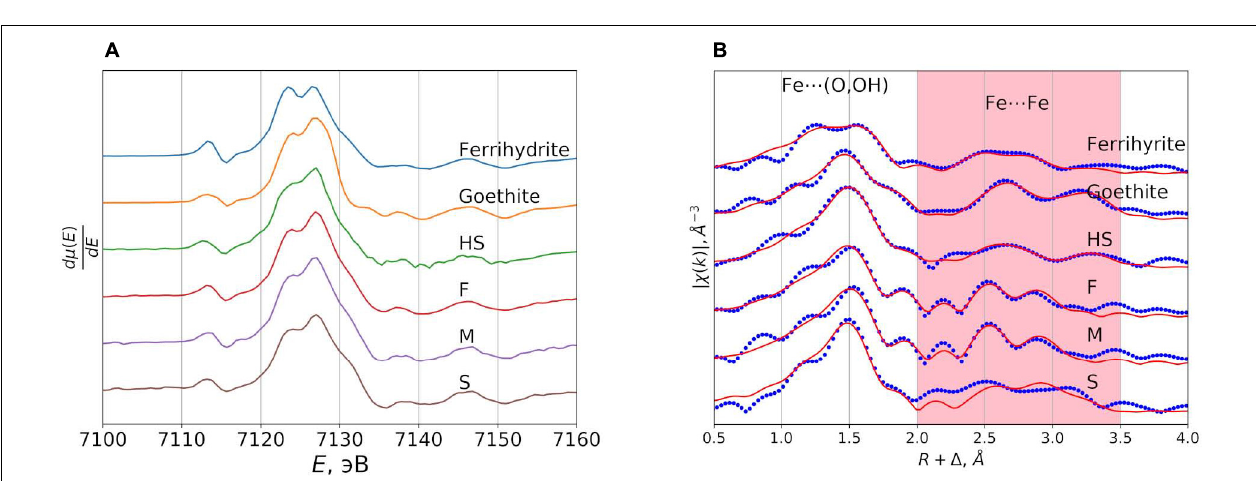
FIGURE 3 | Results of ED integration in reciprocal space (A) and in direct space, after background removal (B) for the products F, M, S. and initial humate (L) in comparison with the XRD data for ferrihydrite.